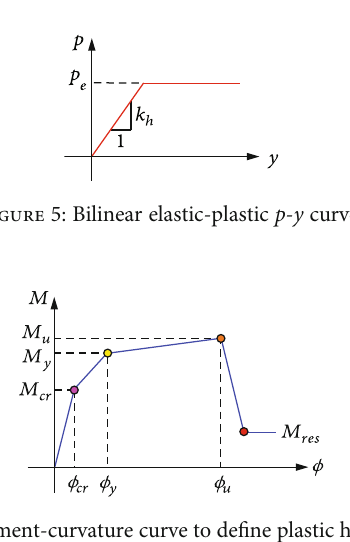
Figure 4: SAP2000 model for case study. (a) Lateral spreading as fl ow displacement. (b) Lateral spreading as fl ow pressure.